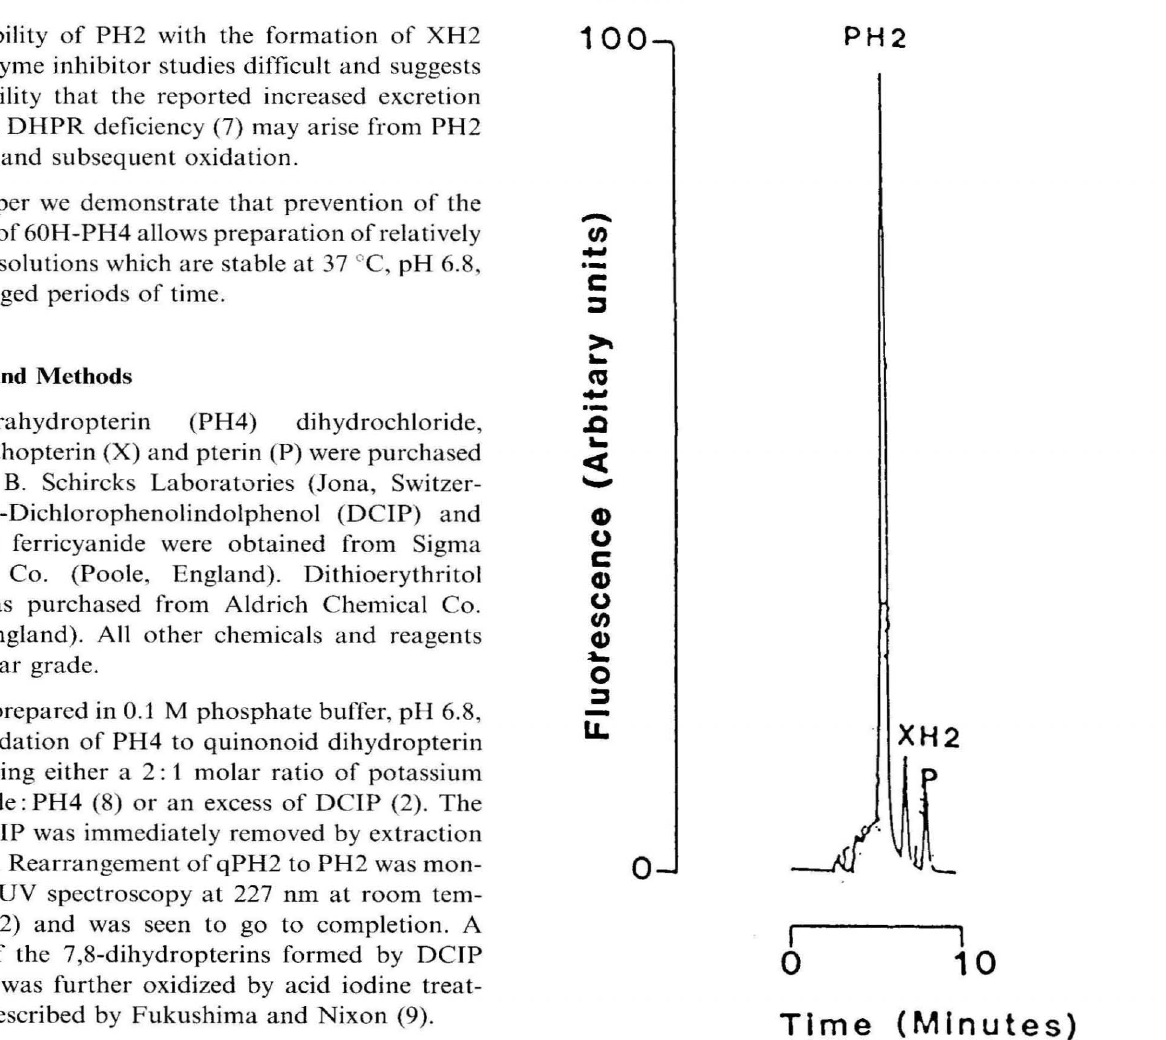
Figure 2. Fluorescence chromatogram (Ex. 360 nm, Em 450 nm) of products formed following DCIP oxidation of tetrahy dropterin. PH4 (SOO J.lM) was oxidised by DCIP (4 mM) in 0.1 M phosphate buffer (pH 6.S). Excess DCIP was